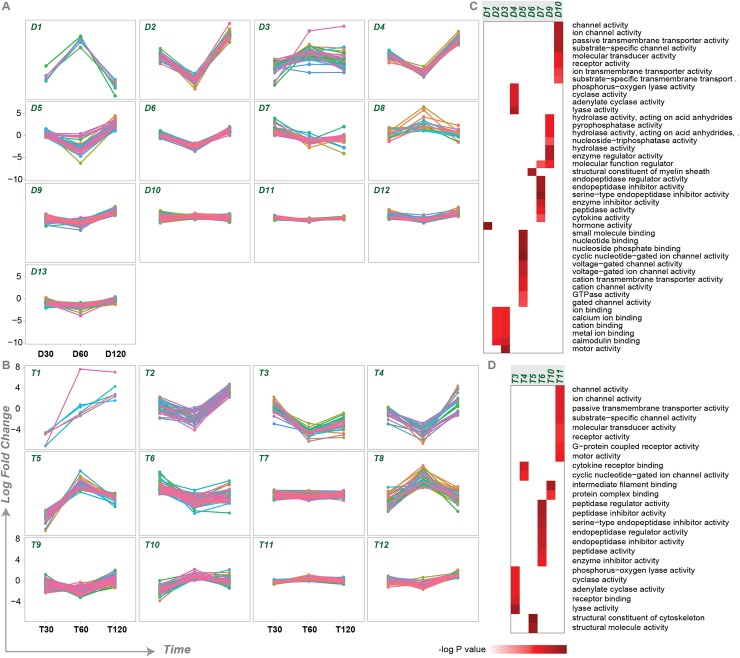
Hierarchical clustering of genes whose expression profiles changed over time in response to a territorial challenge (DEGx) and their functional enrichments.Hierarchical clustering grouped together genes with similar expression profiles over time. 13 clusters were identified in diencephalon (D1-D13, A). 12 clusters were identified in telencephalon (T1-T12, B). Each line represents the expression pattern of a different gene, where positive fold change indicates upregulation and negative fold change indicates downregulation in response to a territorial challenge. Clusters of genes with similar expression profiles (columns) had different GO molecular functions associated with them (rows); C) diencephalon; D) telencephalon. Some clusters did not have significant functional enrichment.